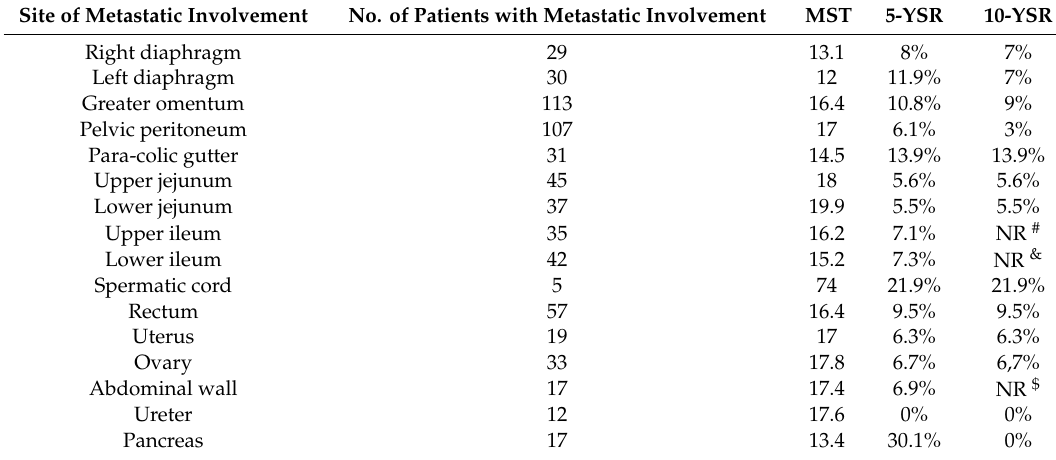
Table 3. Median survival time, and 5- and 10-year survival rates of patients with metastasis on the peritoneal sectors and organs after comprehensive